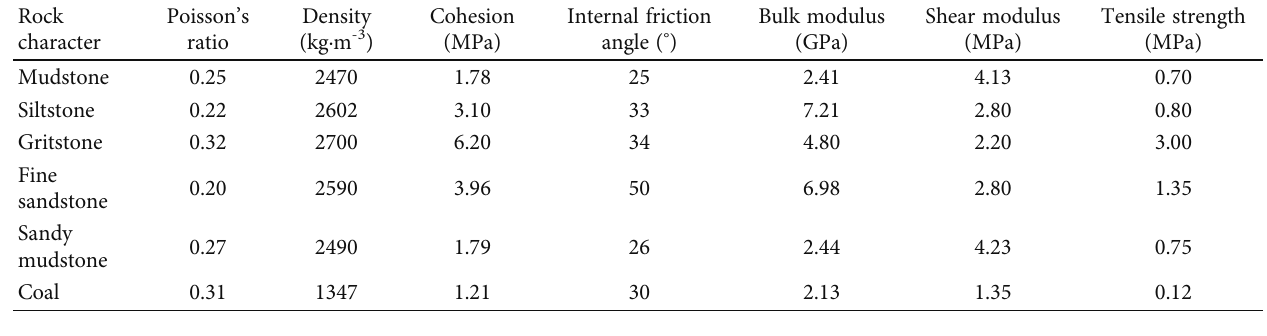
Figure 2: Numerical simulation model. Table 1: Properties of coal and rock mass used in the numerical model.